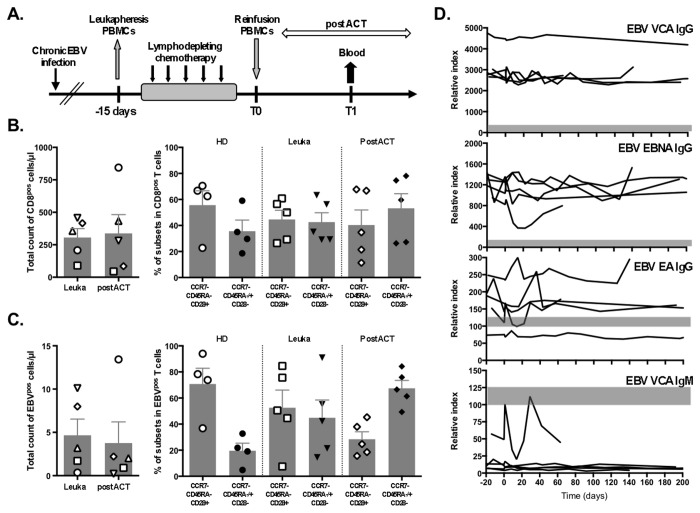
Direct ex
vivo analysis of HLA-A*0201/BMFL1 specific CD8 T cells from healthy donors and melanoma patients.
A. Schematic representation of non-myeloablating lympho-depleting treatment followed by ACT of PBMCs for melanoma patients. Blood samples were analyzed for all patients at the leukapheresis time-point (Leuka) before TLD chemotherapy and post-ACT (time-point T1), which corresponded to day 32 (patient LAU 1144), day 45 (LAU 1013), or day 60 (LAU 618, LAU 936, and LAU 672). B. Left panel; total counts of CD8 T cells from five melanoma patients at Leuka and post-ACT. Right panel; phenotype of total CD8 T cells showing proportions of early-differentiated (EM28pos; CCR7negCD45RAnegCD28pos) and late-differentiated (comprising of EM28neg; CCR7negCD45RAnegCD28neg and EMRA; CCR7negCD45RAposCD28neg) subsets from four healthy donors (HDs) and from five melanoma patients at Leuka and post-ACT. C. Left panel; total counts of EBV-specific CD8 T cells in peripheral blood from five melanoma patients at Leuka and post-ACT time points. Right panel; phenotype of EBV-specific CD8 T cells showing proportions of early-differentiated (EM28pos; CCR7negCD45RAnegCD28pos) and late-differentiated (comprising of EM28neg; CCR7negCD45RAnegCD28neg and EMRA; CCR7negCD45RAposCD28neg) subsets from four healthy donors and from five melanoma patients at Leuka and post-ACT. D. EBV-specific antibody levels measured in plasma samples from five melanoma patients at various time-points before and after lympho-depleting treatment. Day 0 on the x-axis represents the day of ACT. Results are represented as arbitrary units on a relative index scale. Plasma level evolution is shown separately for each anti-EBV antibody (anti-VCA IgM and IgG, anti-EBNA IgG and anti-EA IgG), and the grey bar represents the cut-off between negative and positive status for each marker.